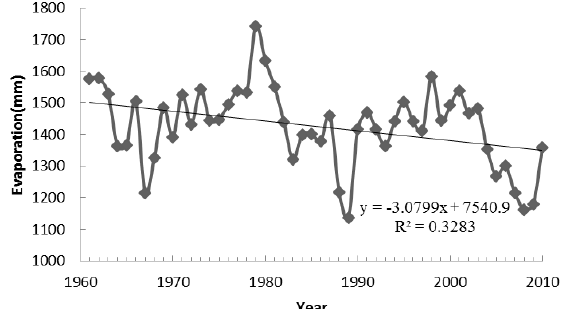
Figure 6. Annual evaporation change from a 20 cm evaporation pan in Qinghai Lake basin from 1961 to 2010.